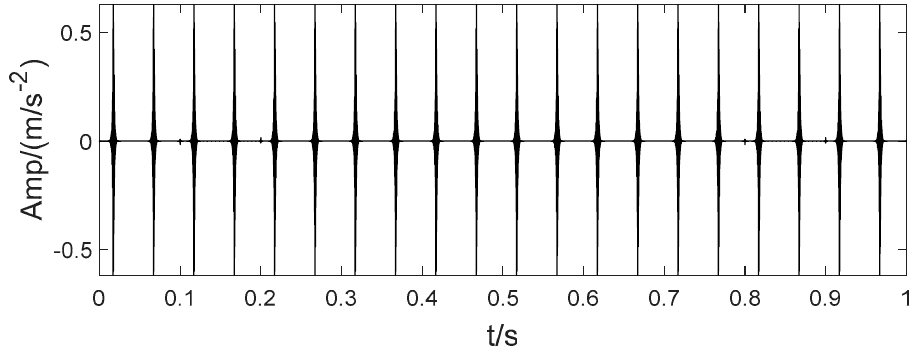
Figure 7. The first obtained IMF component.